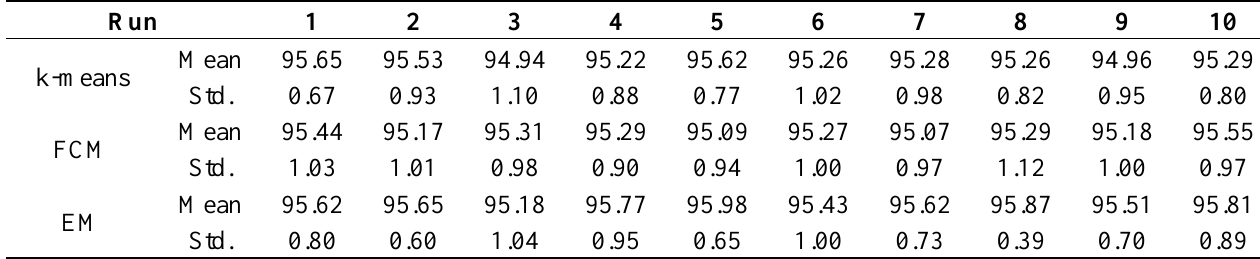
Table 10. Classification accuracies for the Indian Pines image with different clustering initializations.